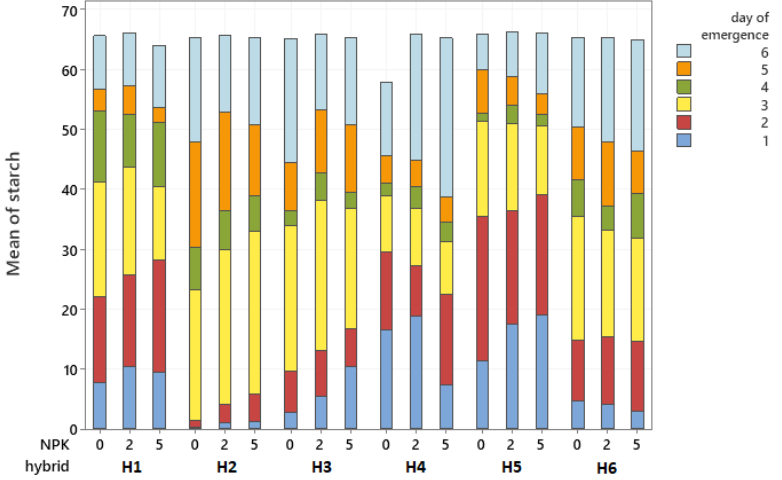
Figure 5. Interaction between hybrids, fertilizer, and day of emergence on starch content.